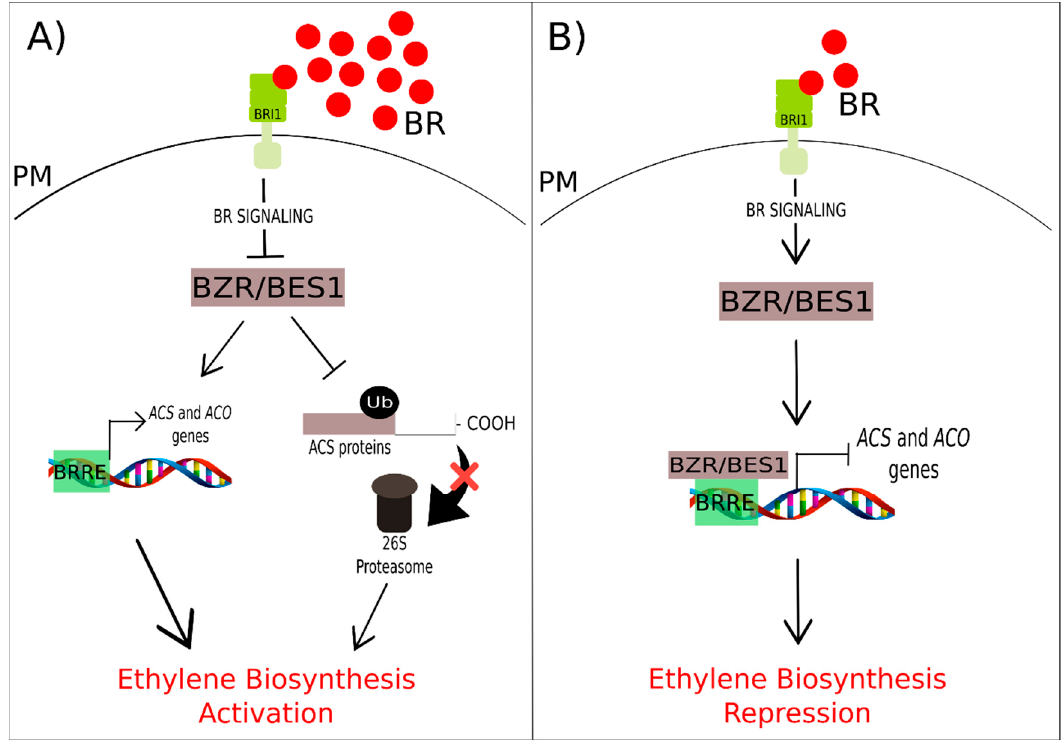
Figure 6. A general simplified model of BR and ethylene cross-talk. The perception of BR begins in its receptor BRASSINOSTEROID INSENSITIVE 1 (BRI1) which activates BR signaling, which, in turn, controls ethylene biosynthesis in a dose-dependent manner. ( A ) High levels of BR decrease the activity of BRASSINAZOLE RESISTANT 1/BRI1-EMS SUPPRESSOR 1 (BZR1/BES1), the major transcription factors of the BR signaling pathway while enhancing the stability of the 1-aminocyclopropane-1-carboxylic acid (ACC)-synthase enzyme (ACS) proteins by preventing its degradation by the 26S proteasome and consequently, activating ethylene biosynthesis. ( B ) Low levels of BR increase the activity of BZR1/BES1, which, in turn, bind to the promoter of the ACC-synthase ( ACS ) and ACC-oxidase ( ACO ) genes, inhibiting their transcription and consequently, repressing ethylene biosynthesis. PM represents the plasma